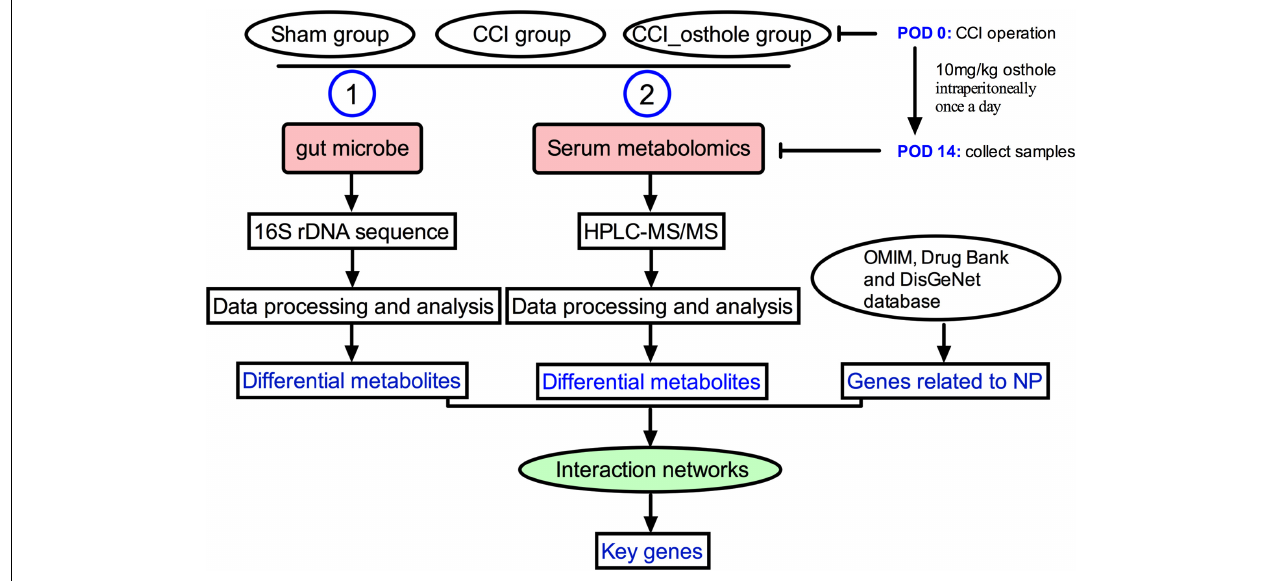
FIGURE 1 | The experimental flow chart. The mechanism of osthole against chronic constriction injury (CCI) neuralgia mice was analyzed by 16S rRNA and